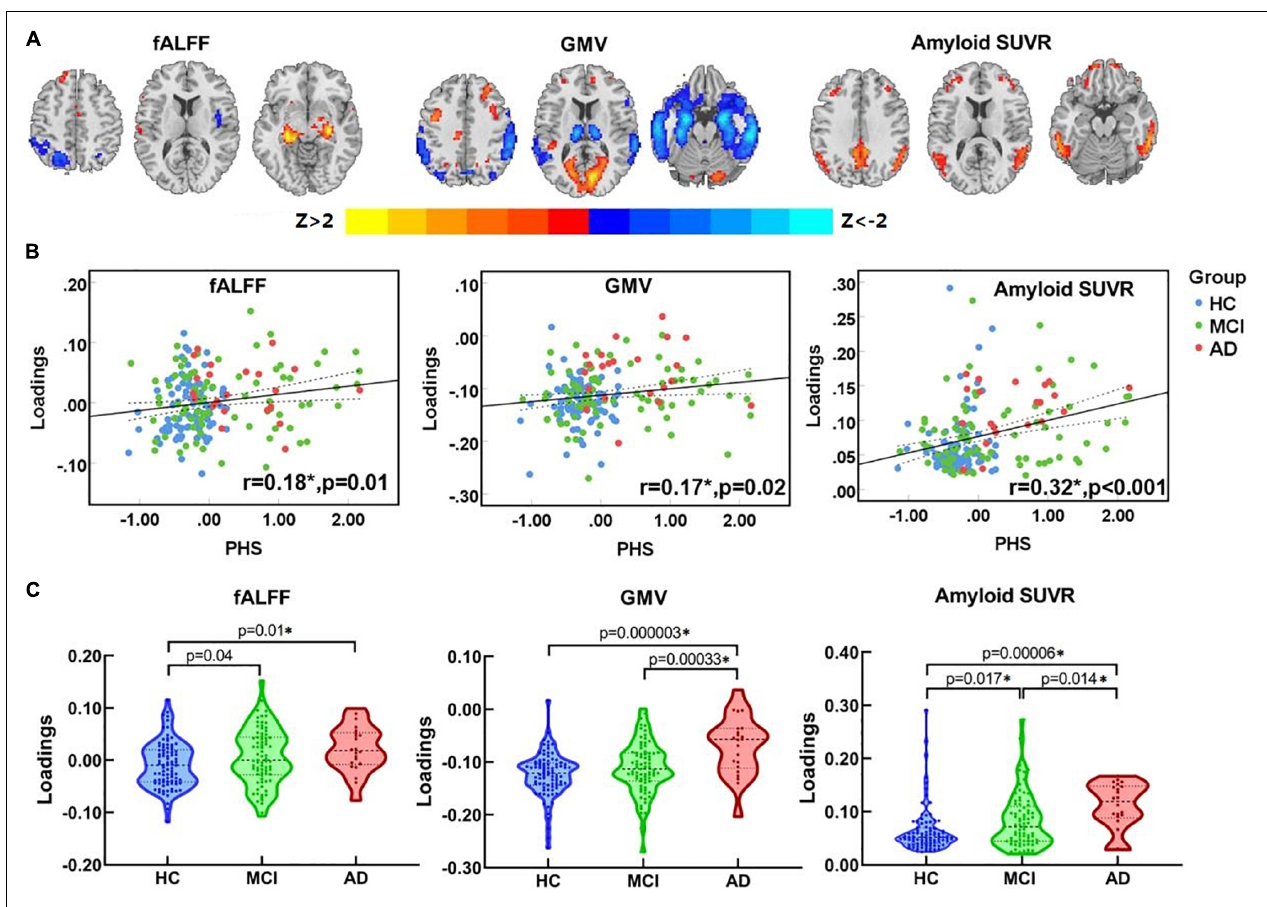
FIGURE 2 | The identified joint component. (A) The spatial maps visualized at |Z| > 2, where the positive Z -values (red regions) means higher fALFF, GMV, and more amyloid deposition, and negative Z -values (blue regions) indicate decreased fALFF, GMV, and less amyloid deposition. (B) The loadings of the identified joint component and PHS were positively correlated (HC, blue dots; MCI, purple square; AD, red triangle) (C) Boxplot of the loading parameters of the identified joint component. *Significant at p < 0.05, FDR corrected. fALFF, fractional amplitude of low frequency fluctuations; GM, gray matter; SUVR, standard uptake value ratios; PHS, polygenic hazard score; HC, healthy control; MCI, mild cognitive decline; AD, Alzheimer’s